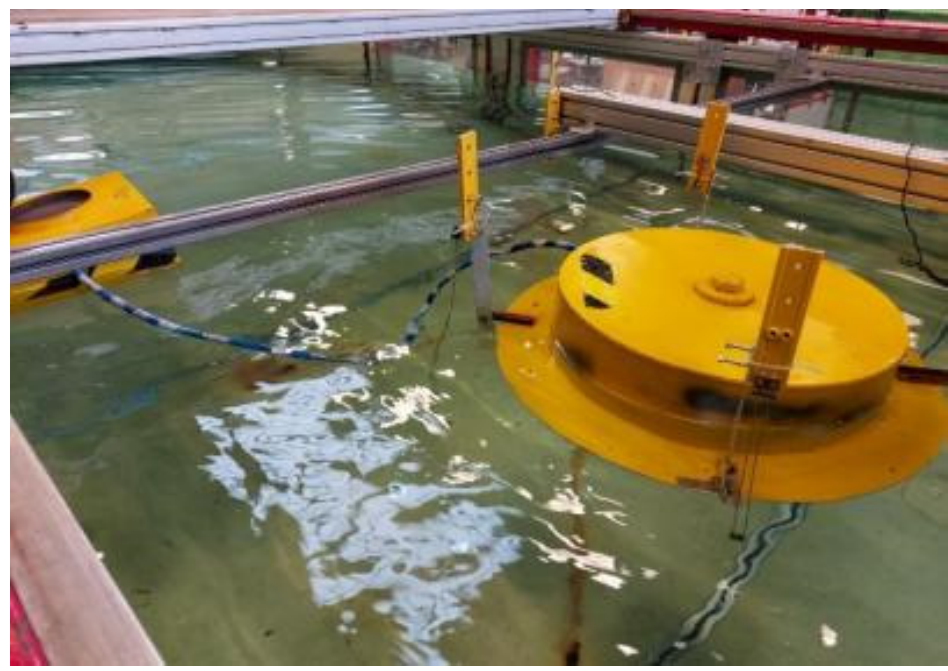
Figure 12. An experimental model in the Lancaster University wave tank facility showing a floating buoy with wave gauges for monitoring the wave forms and position of the buoy.